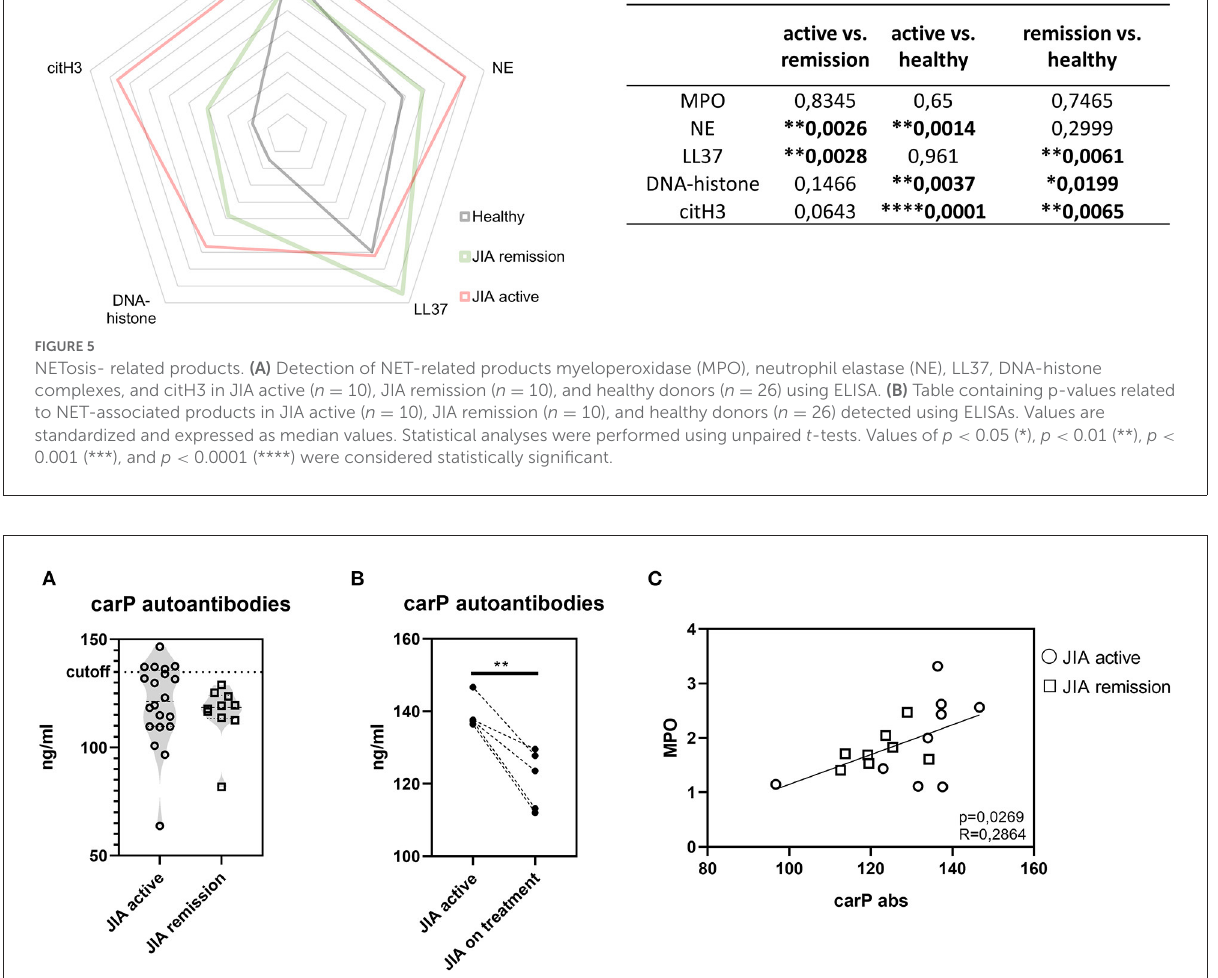
as an autoantigen for pathogenic Th17 lymphocytes (46,